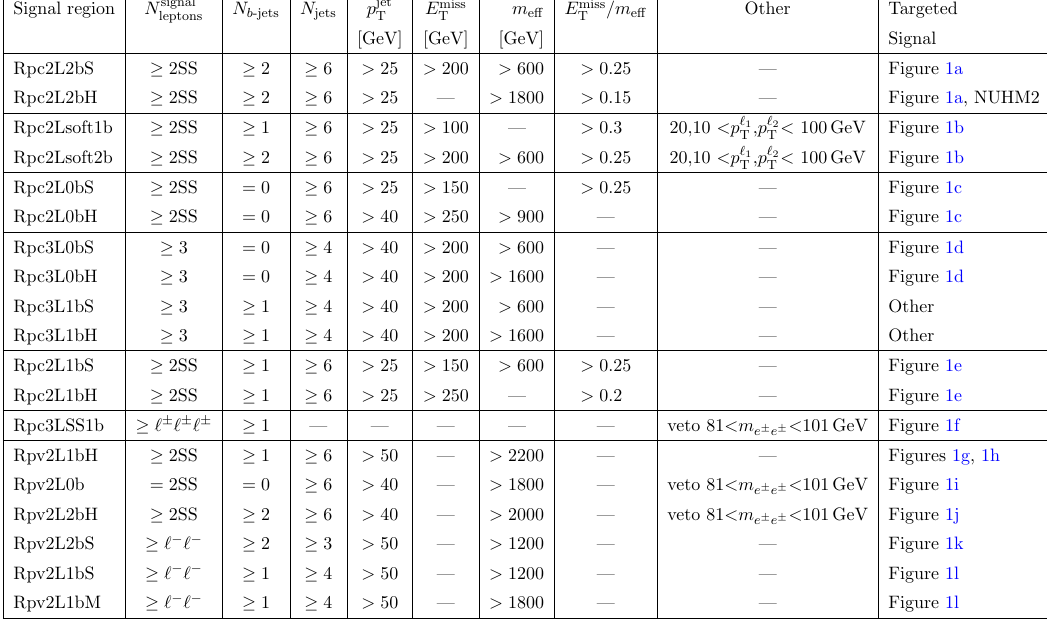
Table 2. Summary of the signal region de(cid:12)nitions. Unless explicitly stated in the table, at least two signal leptons with p T > 20 GeV and same charge (SS) are required in each signal region. Requirements are placed on the number of signal leptons ( N signal 20 GeV ( N b -jets ), the number of jets ( N jets ) above a certain p T threshold ( p jet E miss / m e(cid:11) . The last column indicates the targeted signal model. The Rpc3L1b and T